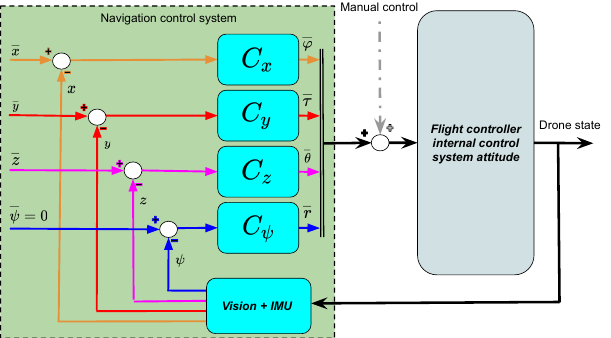
Figure 6. Control architecture. The navigation control system is a feedback control loop composed by four PID controllers, respectively C x , C y , C z and C ψ one for each pose degree of freedom, and a position estimation module fusing together stream data from the IMU and the Raspicam camera. C k , with k ∈ { x , y , z } , have as input signals drone position errors and provide in output an attitude reference signal to be sent to the low-level module. Instead, C ψ takes in input an error signal on ψ and returns a reference for the yaw angular